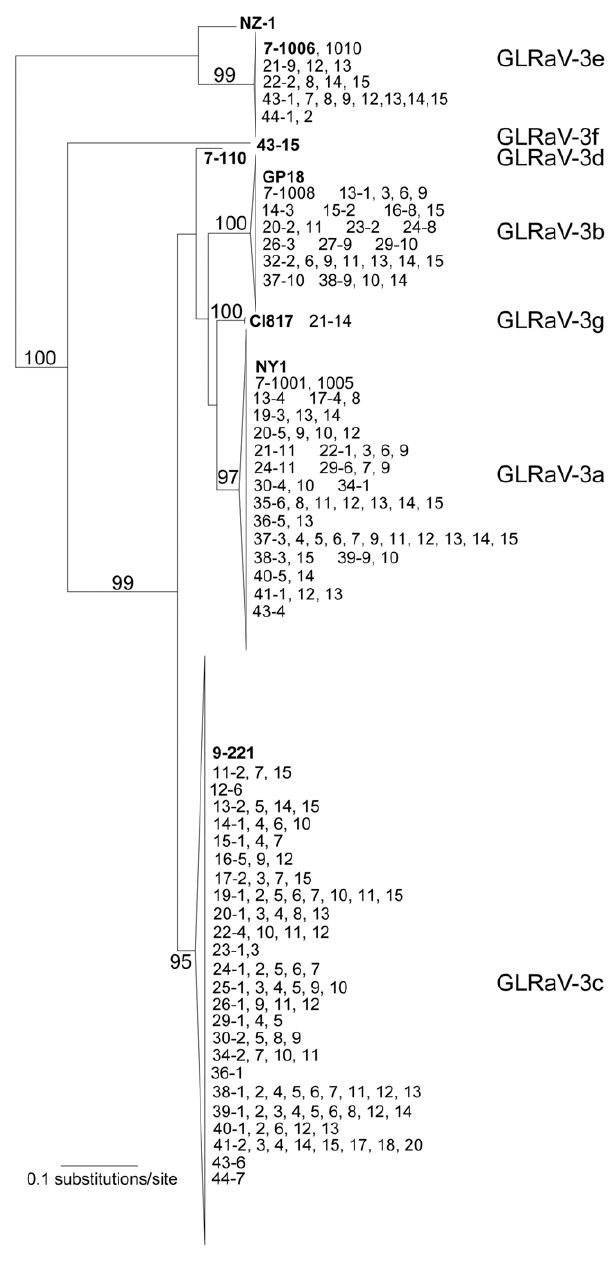
Figure 2. Maximum likelihood tree of a 428 bp segment of the CP gene of GLRaV-3 isolates from Napa Valley. Representative global isolates are in bold for reference. Individual sample number is listed in front of its respective block number (first number, before the dash), numbers after successive commas represent samples from the same block; longer spaces between blocks in the same line were occasionally used due to space limitations, and represent samples from other blocks. Phylogenetic clades were labeled based on Wang et al. (20) and this work. The tree is midpoint rooted for clarity of presentation and $ 70% branch support values are presented; non- supported branches were collapsed for clarity.